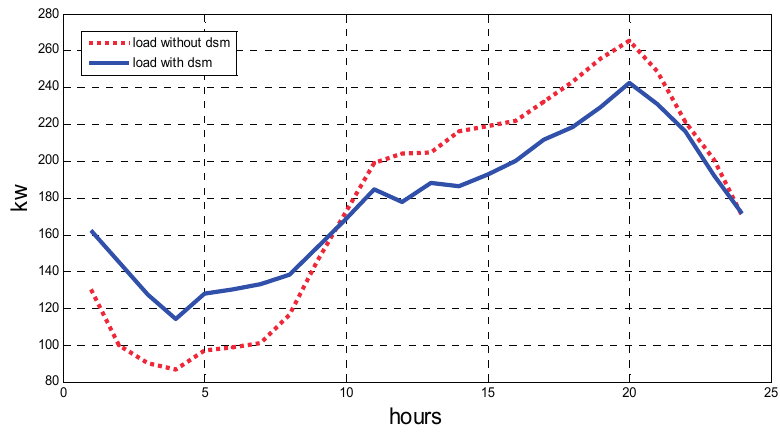
Figure 5. Load profile with and without demand side management (DSM).